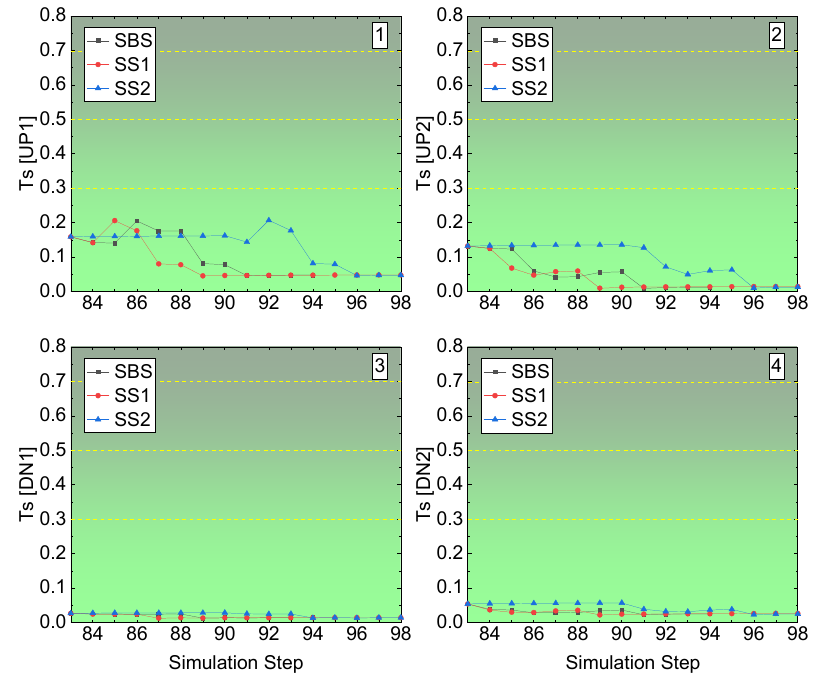
Figure 16. Ts value of the left-edge stope access to undercuts in Sill-1.